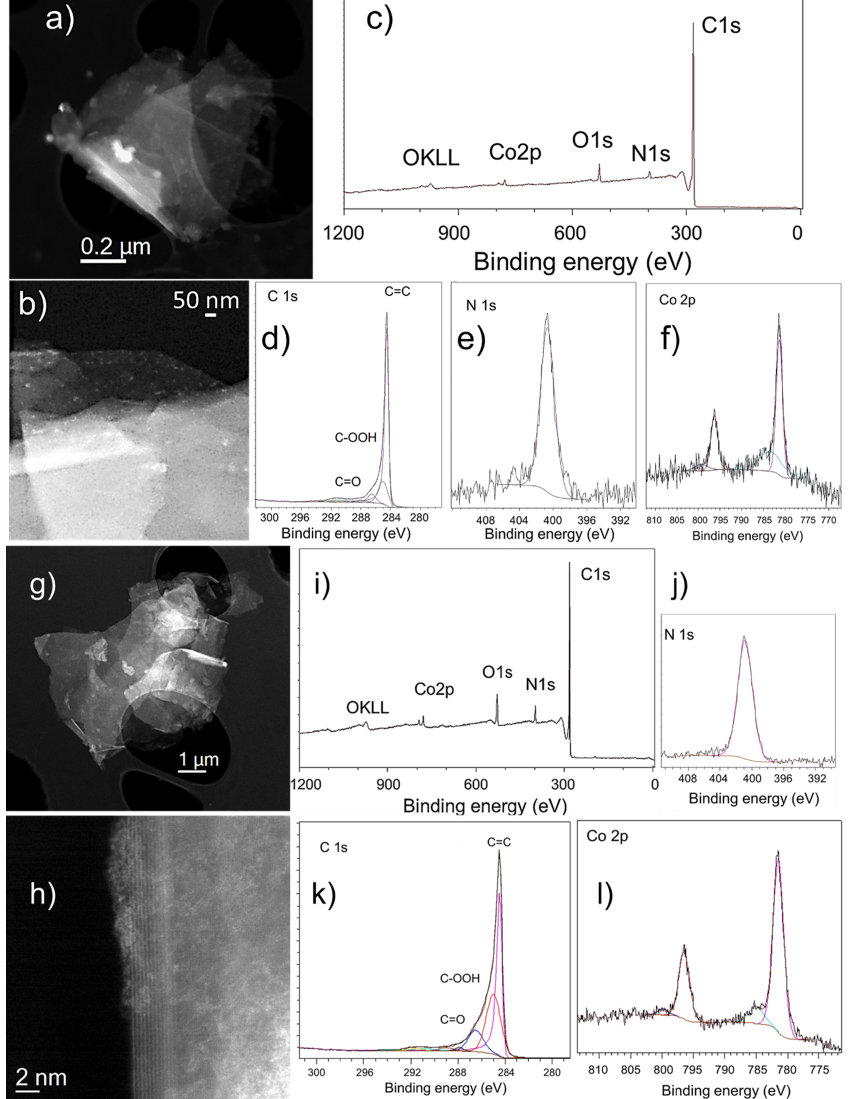
Figure 5. ( a,b ) and ( g,h ) HAADF-STEM (low-magnification ( a,g ), high-magnification ( b,h )) micro- graphs of [Co]-pyr-graphene and [Co]-imi-graphene, respectively. ( c ) and ( i ) XPS survey spectra of [Co]-pyr-graphene and [Co]-imi-graphene, respectively. ( d–f ) and ( j–l ) HR-XPS spectra of [Co]-pyr- graphene and [Co]-imi-graphene, respectively.